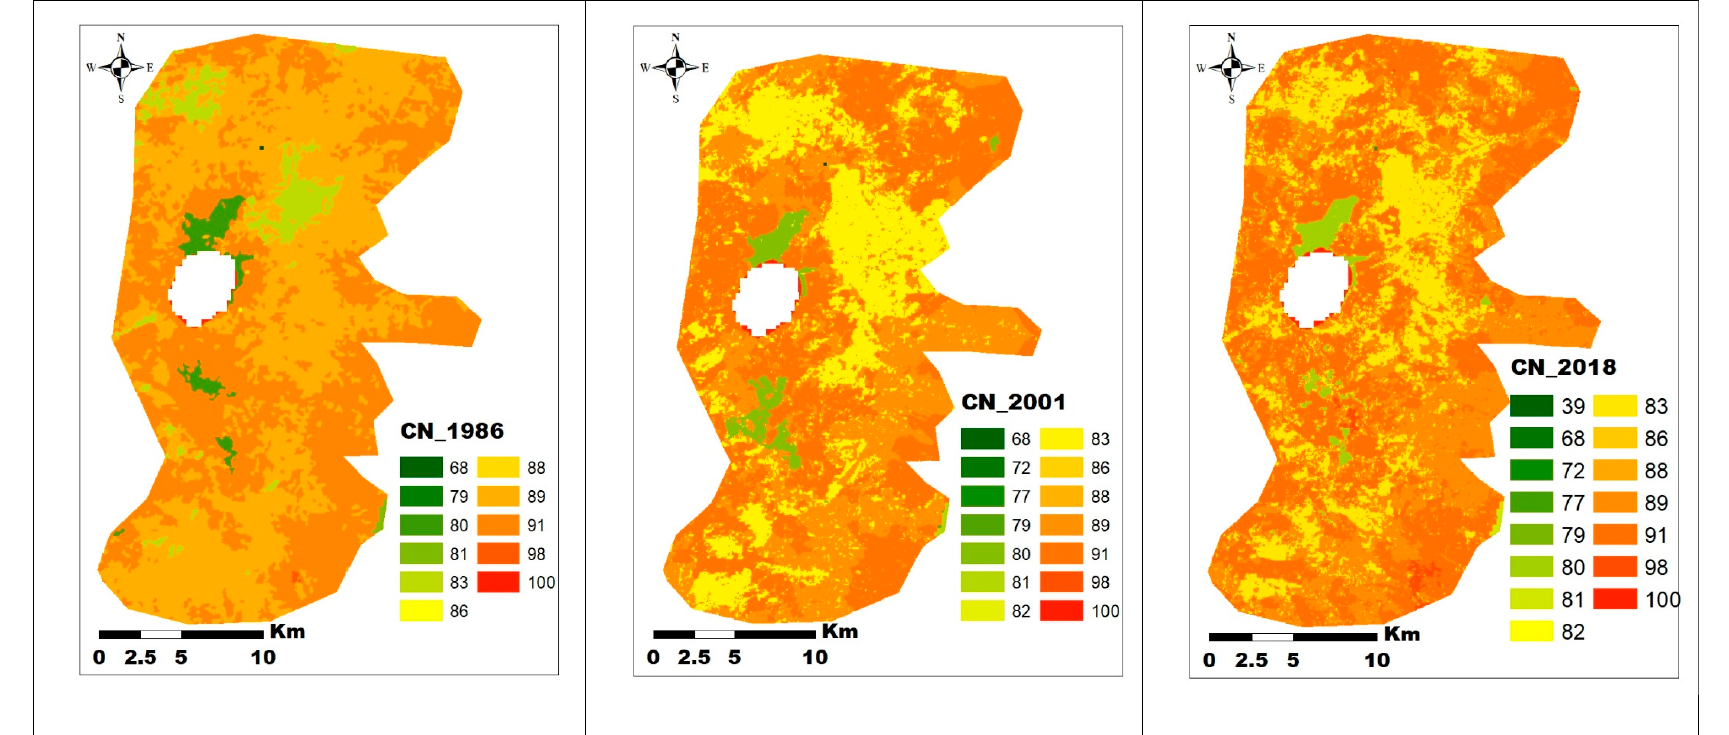
Figure 6. Curve numbers (CN) based on digital elevation model (DEM) of study area.